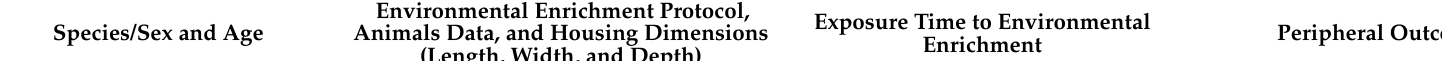
Table 5. Sample description and characterization of environmental enrichment protocols and Cytokines and Immune Cells in Peripheral